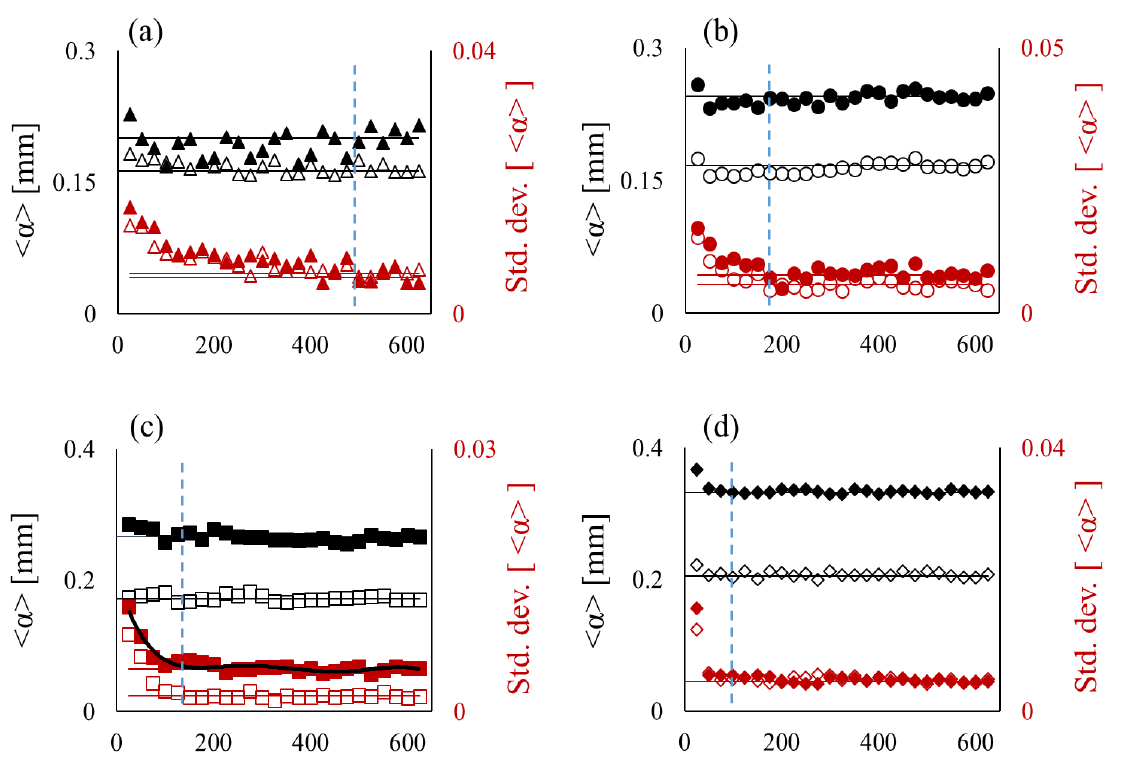
Figure 6: The interface position α averaged over 25 s, a timescale larger than that for the fluctuations, for (a) 7 s −1 , (b) 9 s −1 , (c) 12 s −1 and (d) 15 s −1 . Protocol 1 (no pre-shear) is closed black symbols and protocol 2 (with pre-shear) is open black symbols. Solid lines represent the average values for the entire experiment. Red symbols are the standard deviations within each 25 s period (closed symbols are protocol 1 and open symbols are protocol 2). Solid red lines correspond to where the standard deviations plateau. The solid black line over the closed red symbols in (c) demonstrates the data smoothing process used to extract timescales. The dotted blue lines correspond to the steady state timescale τ . ss